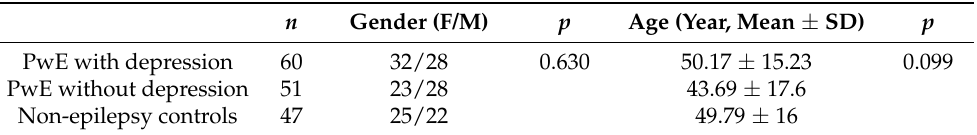
Table 1. Comparisons of the demographic characteristics among PwE with depression, PwE without depression and non-epilepsy controls.